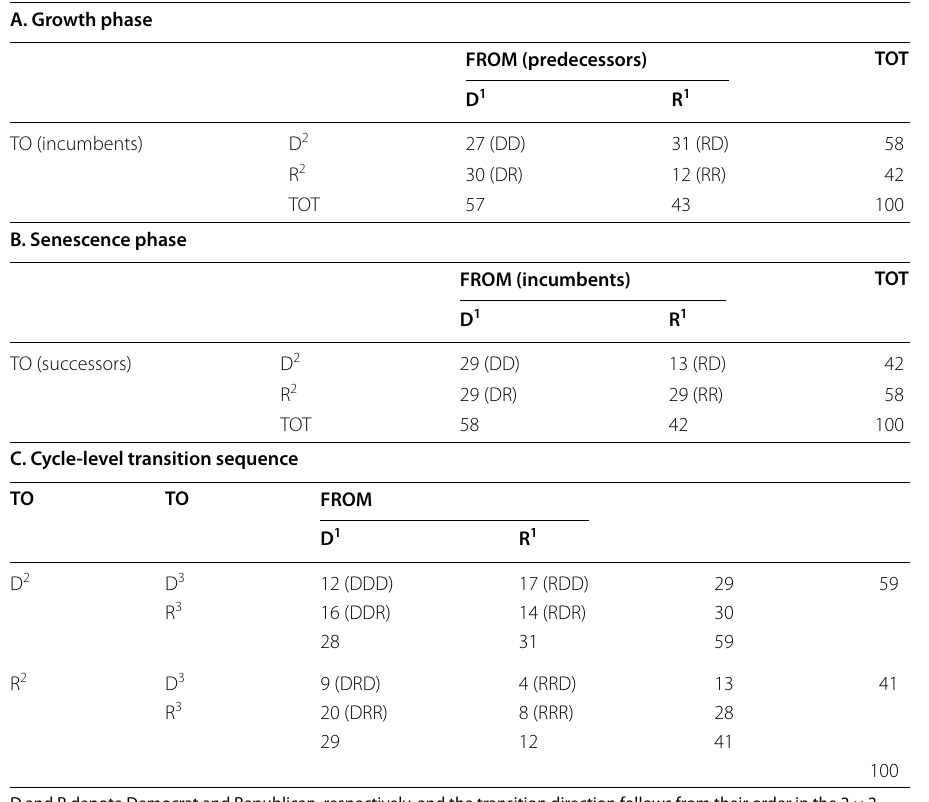
Table 1 Three sets sub-tables containing numbers of party transitions for the 100 members of